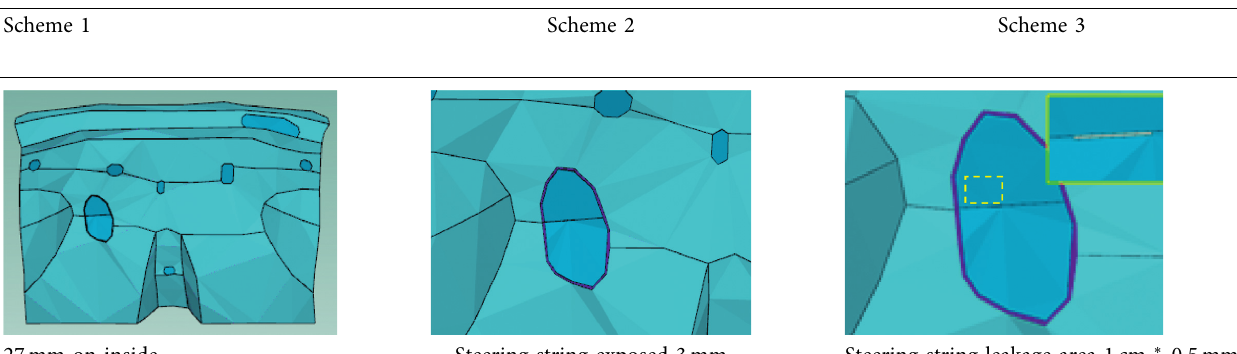
Table 6: Three schemes of leakage.